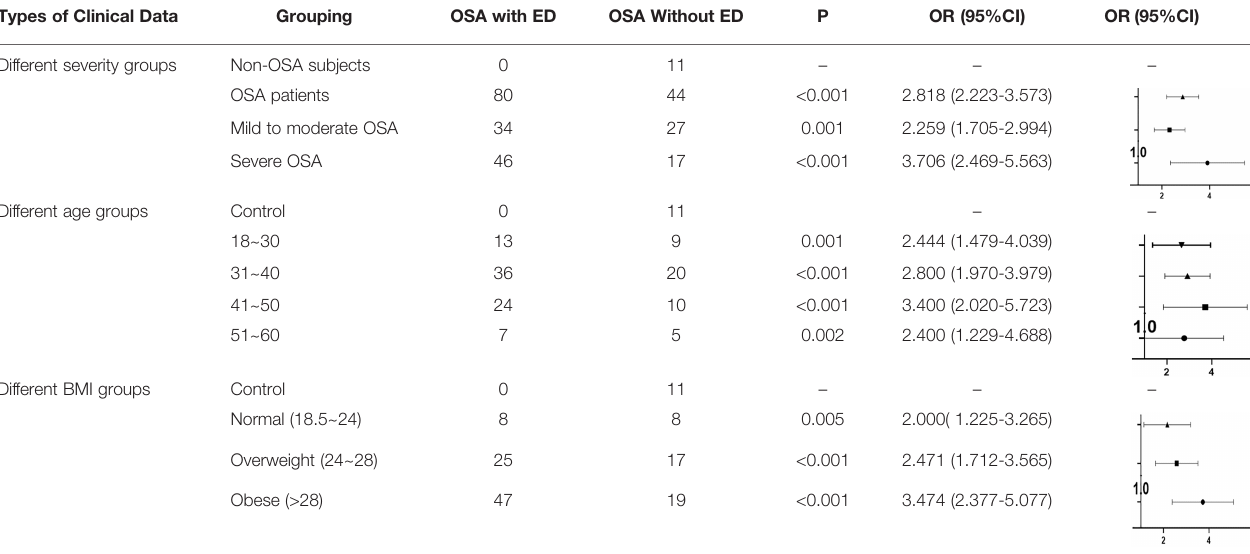
TABLE 3 | The prevalence of ED in patients with OSA of different types of clinical